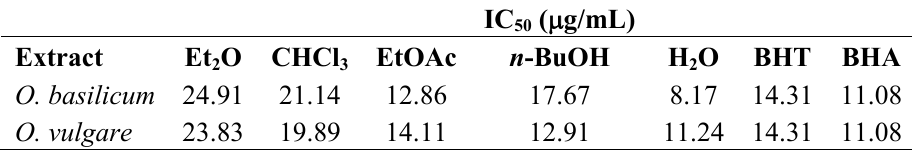
Table 2. IC values ( μ g/mL) of the neutralization of DPPH radical with O. basilicum and 50 O. vulgare